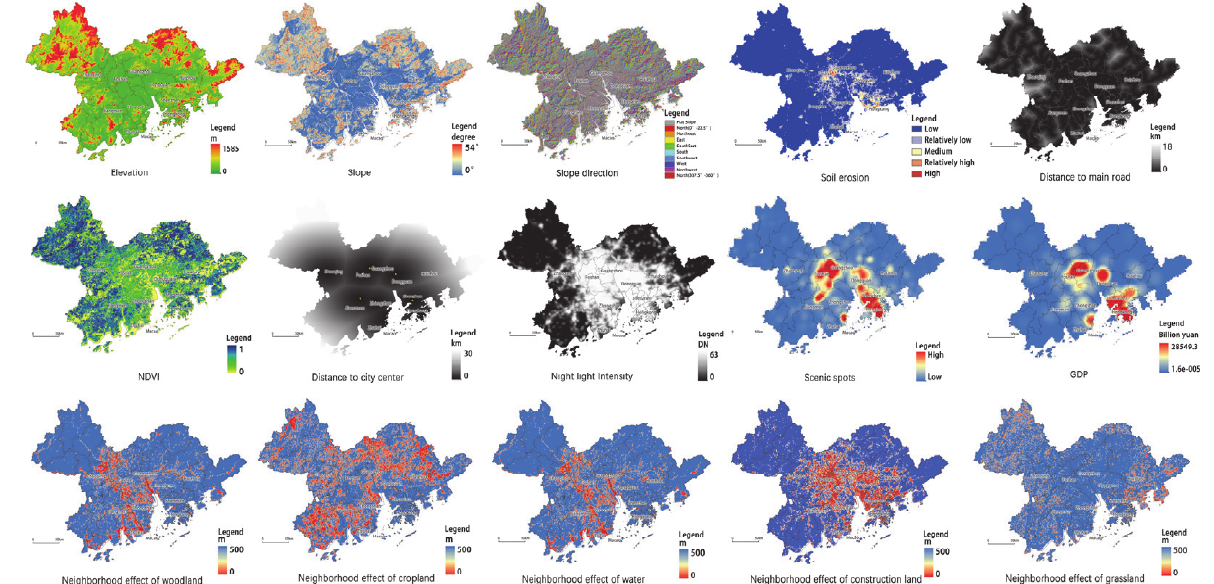
Figure 5. Drive factors in the GHM-GBA.